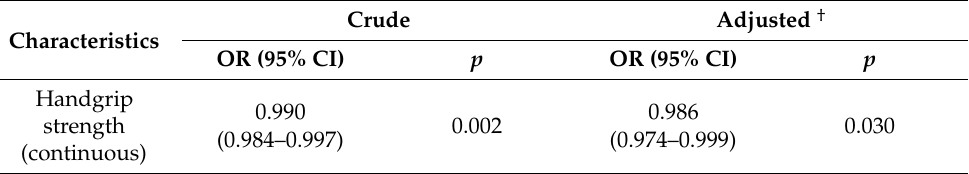
Table 3. Factors associated with periodontitis based on multiple logistic regression